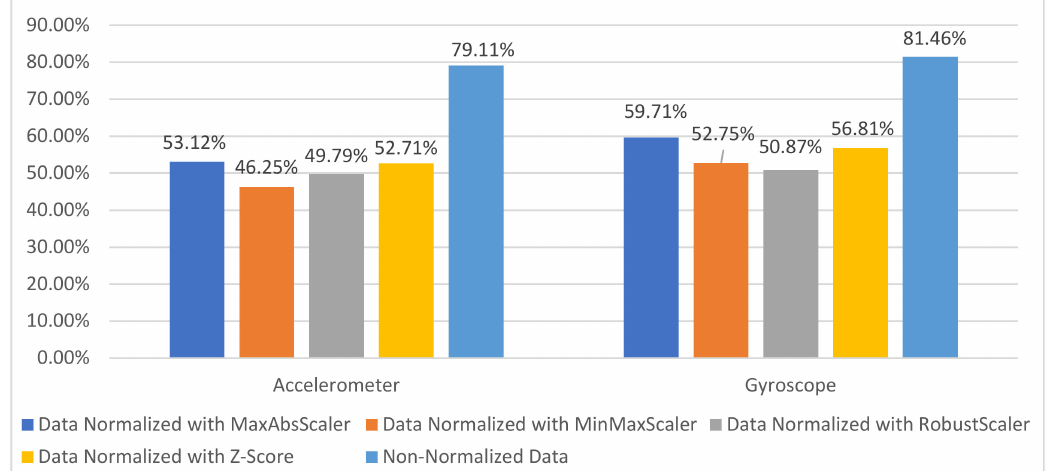
Figure 2. Results on the data classification with accelerometer and gyroscope